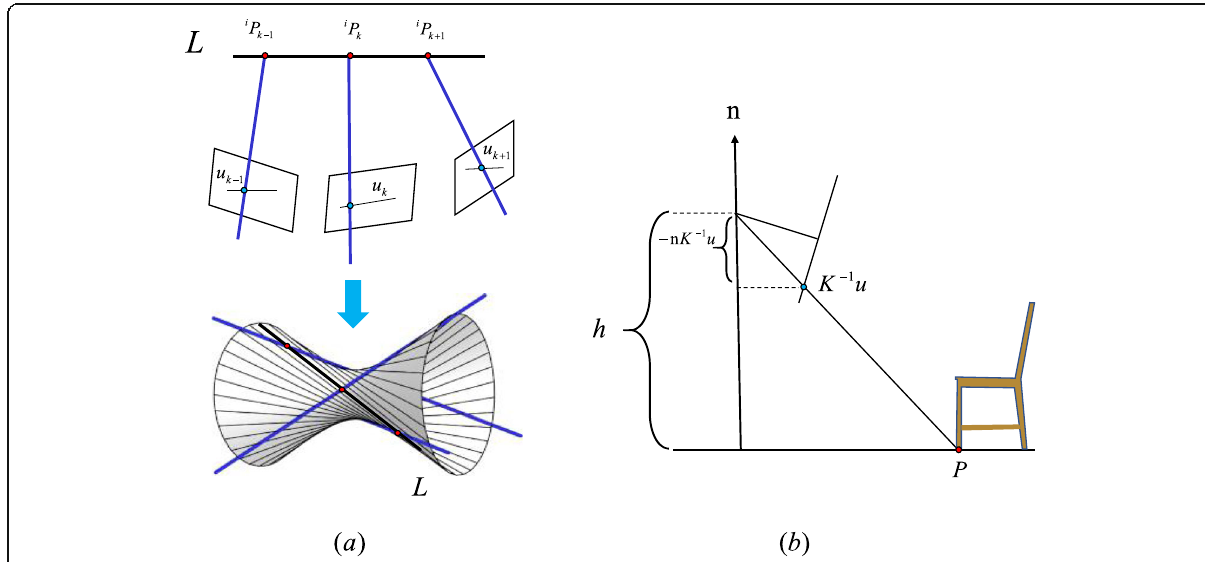
Fig. 3 Approaches to addressing dynamic feature reconstruction for a monocular camera. ( a ): Trajectory triangulation with a line assumption. When the number of views t is three, the solution is a ruled surface. Therefore, to obtain a unique result, t must be at least five; ( b ): Illustration of reconstruction using the ground